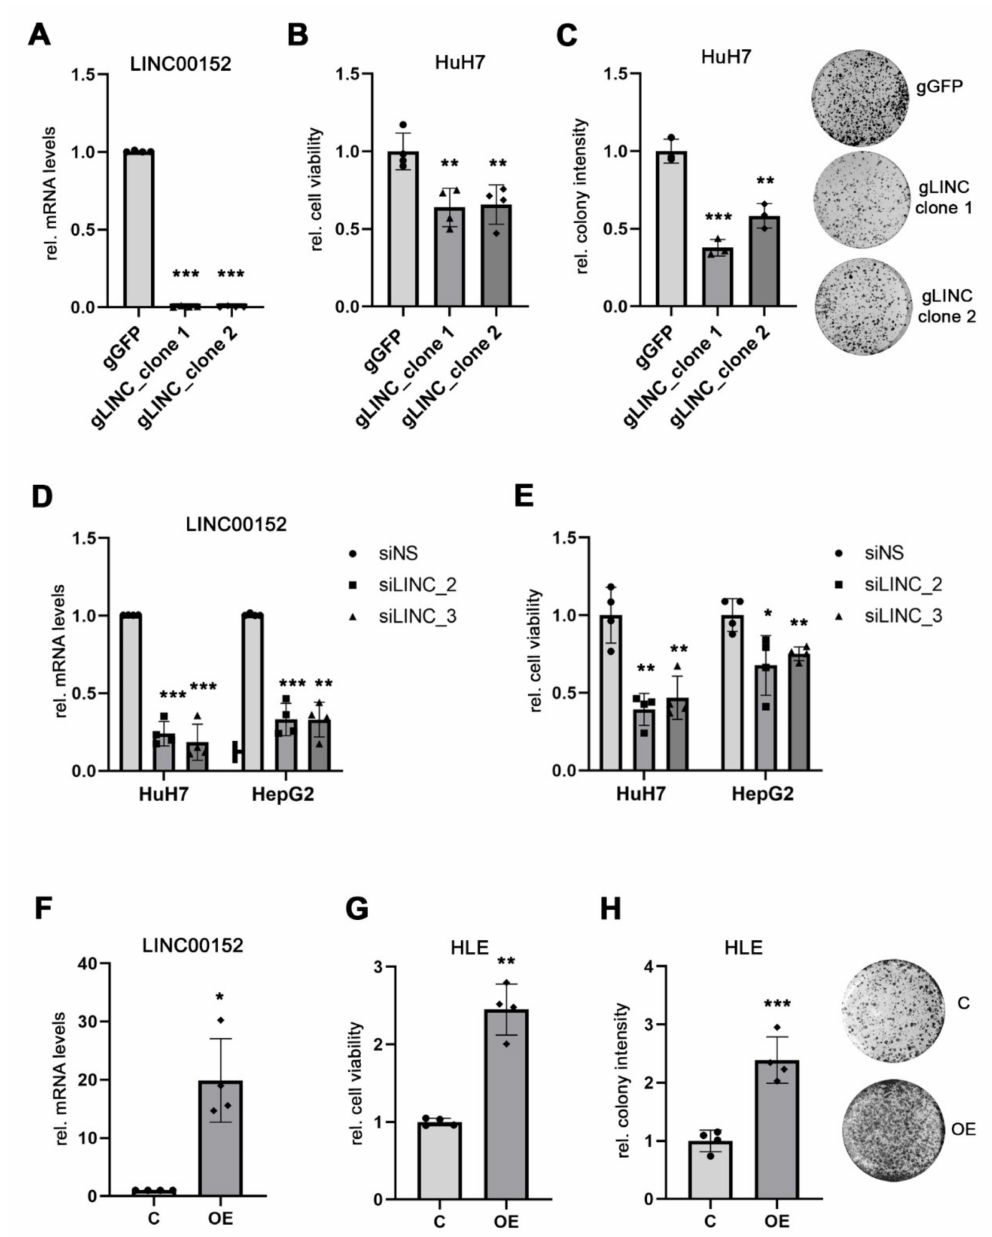
Figure 1. LINC00152 expression affects cell viability of human HCC cell lines. ( A ) HuH7 cells 0 were engineered with CRISPR/Cas9 technology to achieve a complete LINC00152 gene knock-out (HuH7 ∆ LINC00152 ). ( B ) Reduced cell viability of HuH7 ∆ LINC00152 clones compared to gGFP control cells. ( C ) Clonogenicity was significantly impaired in HuH7 ∆ LINC00152 clones compared to control cells. ( D , E ) Efficient siRNA-mediated LINC00152 knockdown decreased cell viability of HuH7 and HepG2 cells. ( F ) Overexpression of LINC00152 in HLE cells transfected with pLV- LINC00152 plasmid. ( G ) LINC00152 overexpression increased the cell viability of HLE cells compared to cells transfected with an empty vector. ( H ) Increased colony formation of LINC00152 -overexpressing cells compared to control cells. Data are presented as mean ± SD of at least 3 independent experiments. Student t -test was used in ( A – C , F ), while Welch’s t -test in ( D , E ): * p < 0.05, ** p < 0.01, *** p < 0.001. Abbreviations: gGFP, guide RNA targeting GFP; gLINC, guide RNA targeting LINC00152 ; siNS, scrambled, nonsense siRNA; siLINC_2/_3, siRNA 2 and 3 specifically targeting LINC00152 ; C, control cells transfected with empty vector; LINC00152 OE, LINC00152 overexpression; OE, overexpression; rel.,